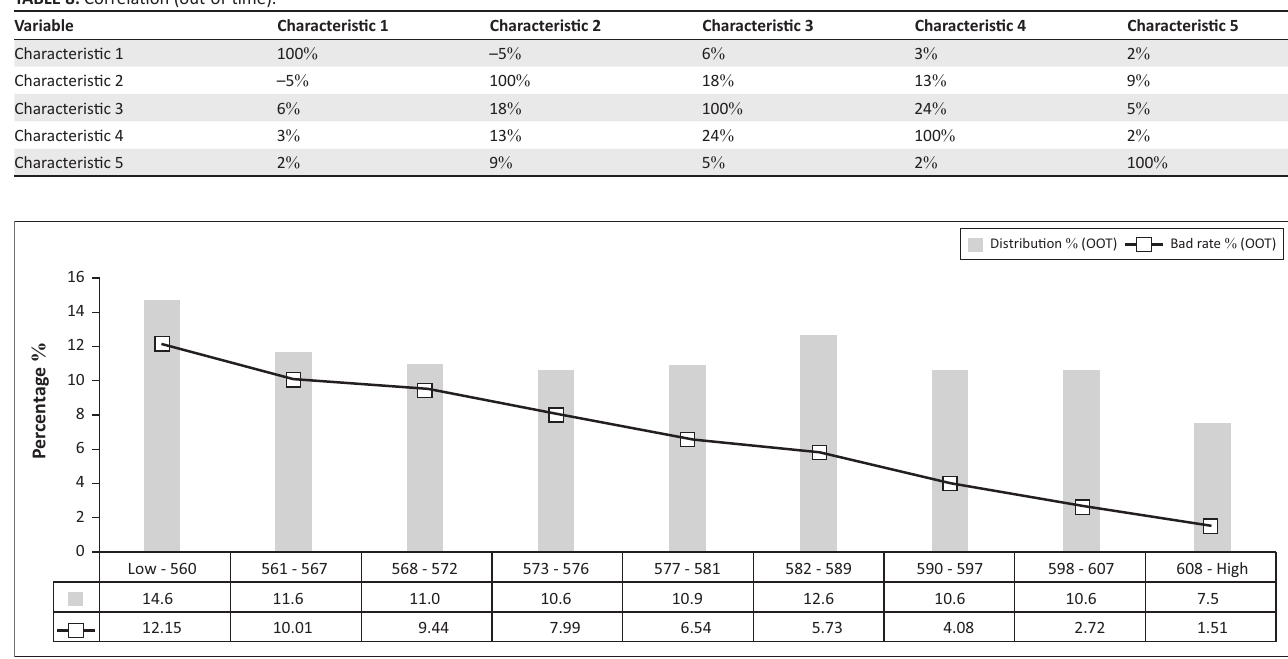
FIGURE 8: Score trend (internal application scorecard) for out-of-time